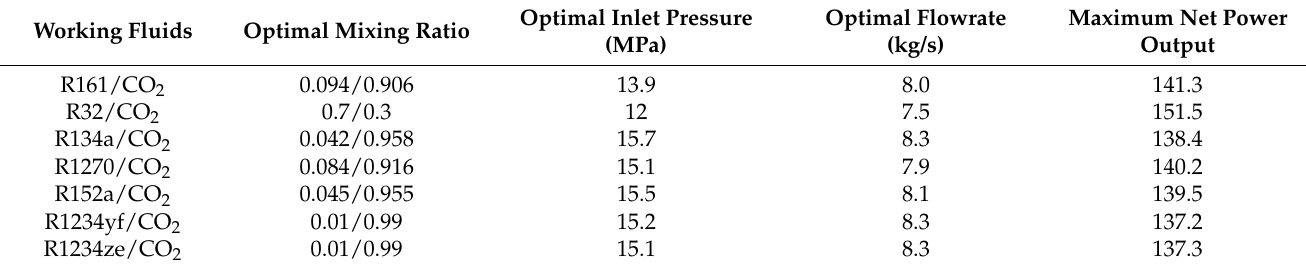
Table 3. Optimal net power outputs of the power cycle using different mixture working fluids (geofluid temperature = 140 ◦